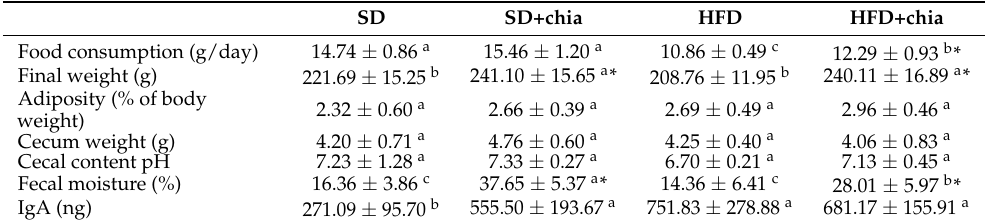
Table 3. Biometric data, consumption data, fecal moisture, cecal content pH and IgA concentration.